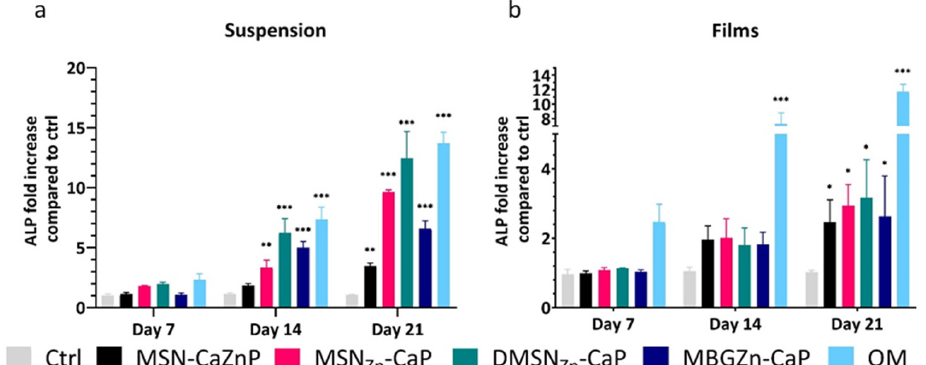
Figure 5. ALP activity in hMSCs normalized to DNA content after exposure to nanoparticles ( a ) to a 70 µ g/mL nanoparticle suspension, ( b ) or cultured on thin nanoparticle films. Data are shown relative to controls (cells not exposed to nanoparticles). The experiments were carried out in triplicate. Significant differences between samples and control groups are calculated by one-way ANOVA followed by Turkey’s multiple comparison, * representing p -values as follows; * p < 0.033; ** p < 0.02; *** p < 0.001.